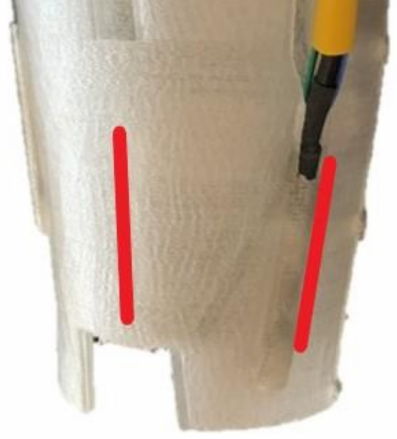
Figure 17. Pressure sensors on the “X” and “Y” axis.